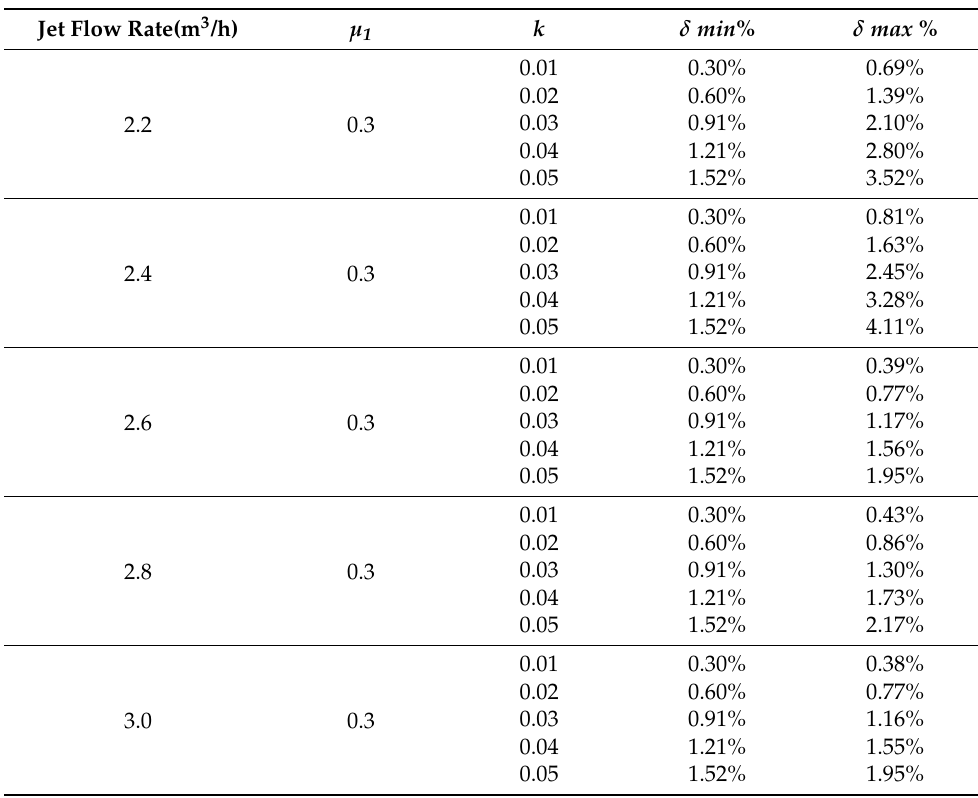
Table 4. Sensor estimated